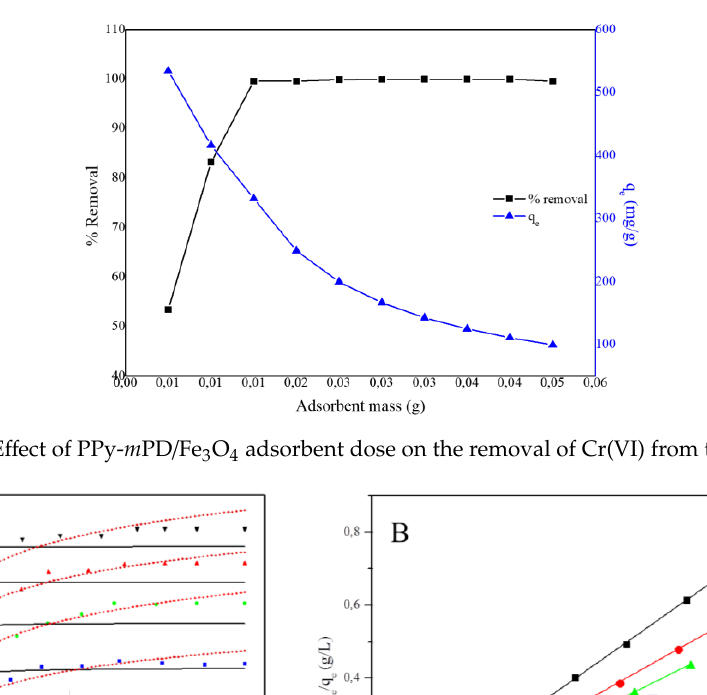
Figure 5. The effect of pH on Cr(VI) by adsorbent ( A ) and IC-ICP-MS chromatograms for analysis of chromium speciation ( B) in standard solutions and the solutions obtained from the pH effect experiments.